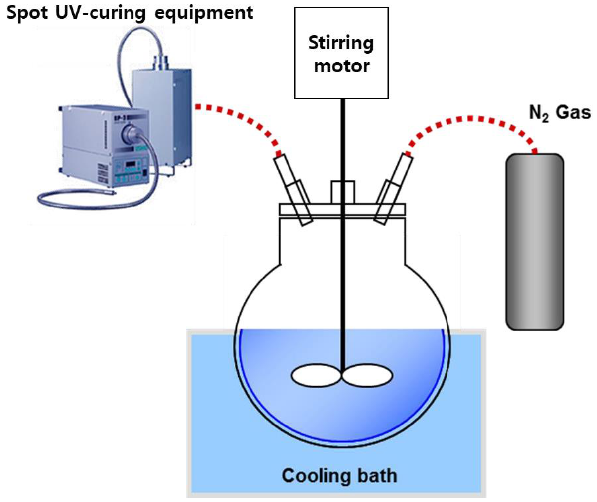
Figure 2. Equipment used for UV-curing-based polymerization.